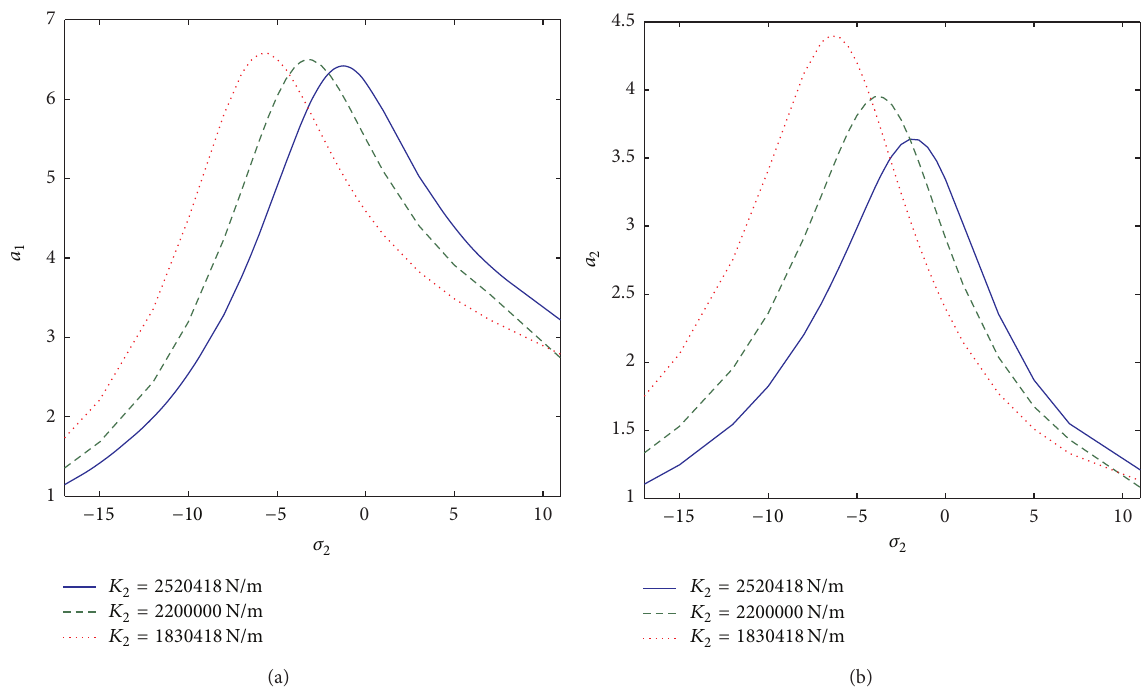
Figure 10: The influence of rubber damping shock absorber’s